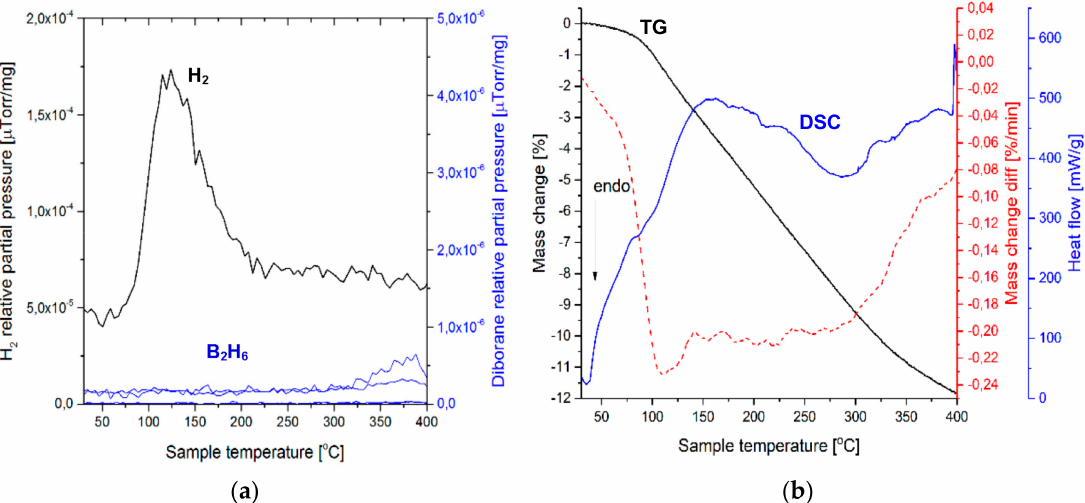
Figure 12. ( a ) Mass spectrometry (MS) (gas desorption spectra) for a ((2NaBH 4 + MnCl 2 ) + 5 wt. % LiNH 2 ) sample ball milled for 0.5 h (Q TR = 36.4 kJ/g) and then extracted at 42 °C/6–7 min evaporation time, using solvent filtration method. ( b ) TGA and DSC curves during desorption. Heating rate 5 °C/min.